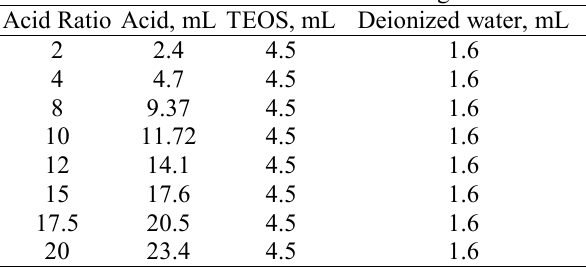
Table 3. Variation of acid volume in sol-gel reaction.